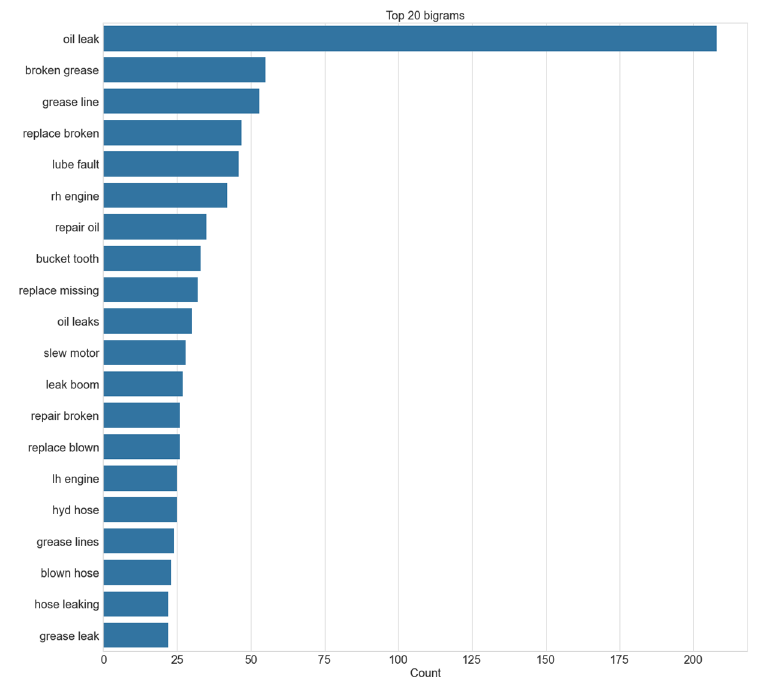
Figure 5. Top 20 bigrams in maintenance records.